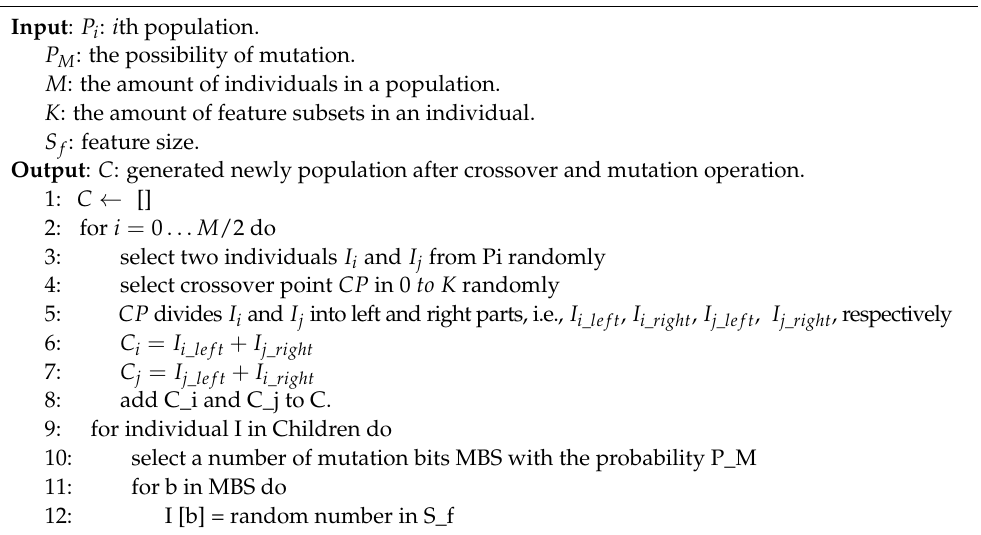
Algorithm 2 Crossover and